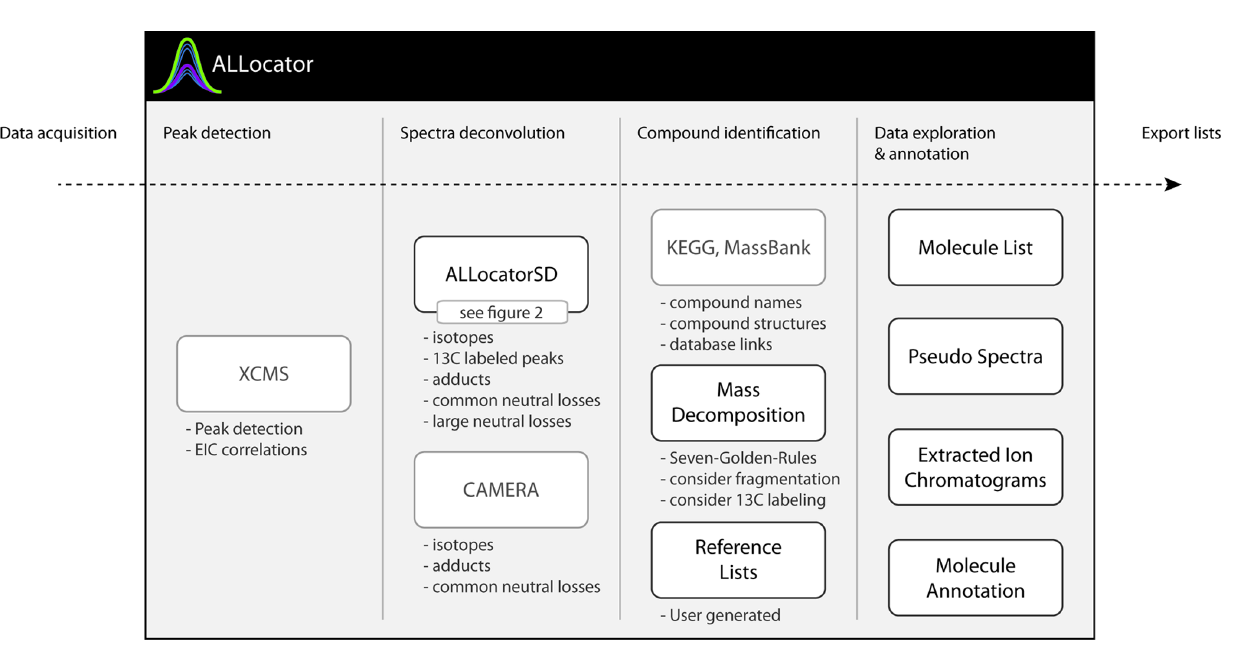
Figure 1. The workflow covered by the ALLocator web platform (integrated third-party features are shown in light gray): After raw data upload, the first step is peak detection. Second, either the new ALLocatorSD algorithm or CAMERA can be applied for spectra deconvolution. Next, tools are provided to identify and annotate detected compounds. Then, data exploration is facilitated through dynamic and interactive visualizations that directly allow to confirm or to modify results of the automated processing steps. In the final step, results can be exported for external